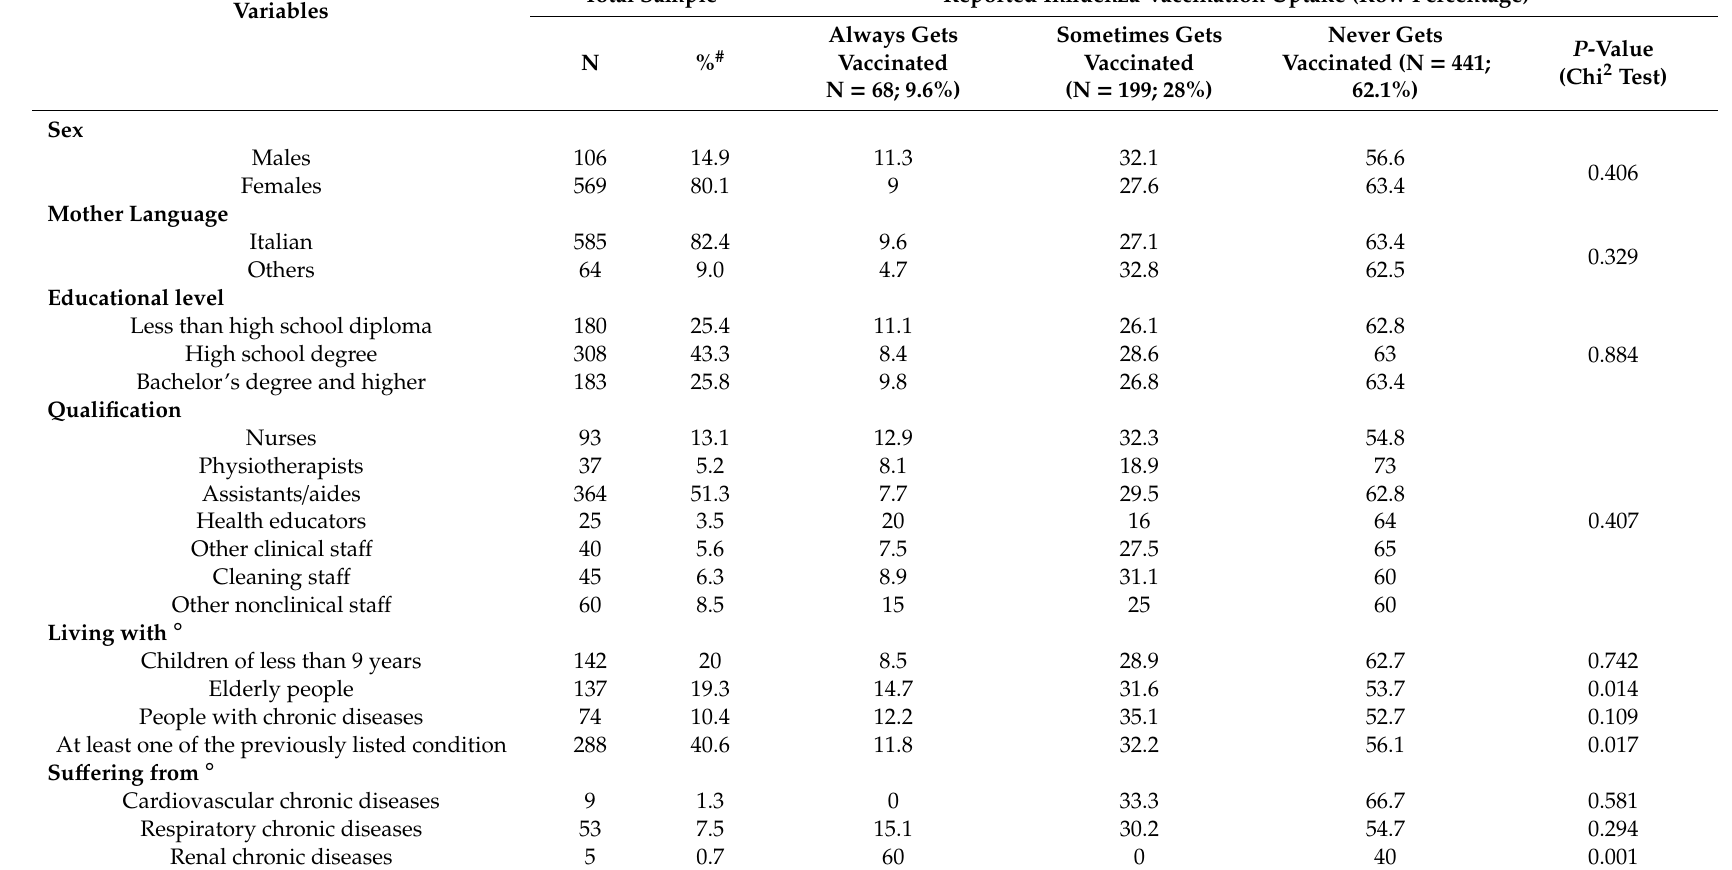
Table 2. Characteristics (categorical variables) of the sta ff (N = 711): total sample and reported influenza vaccination uptake in 2016–2017, 2017–2018 seasons and intention to vaccinate in